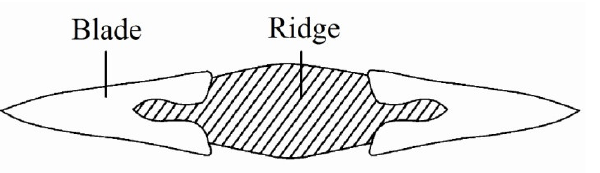
Figure 1. Sketch diagram of the two-times casting for making the bi-metallic bronze sword.